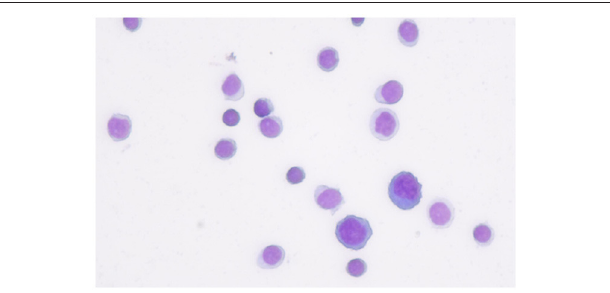
FIGURE 2 | The first cerebrospinal fluid cytology from the patient showed that most of inflammatory cells were lymphocyte.